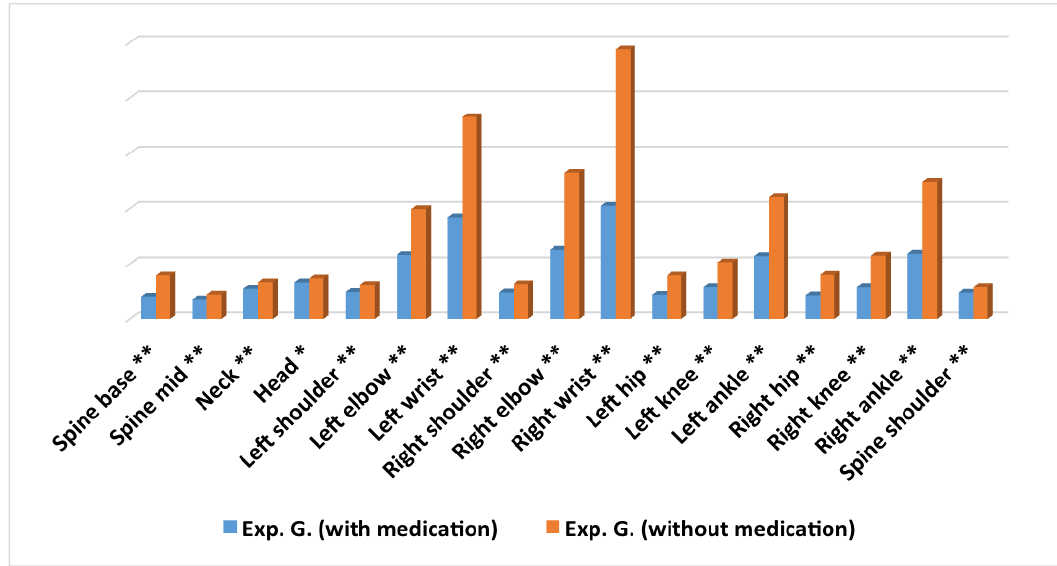
Figure 8. Average differences in movement for every joint within the experimental group with and without medication intake. ** = p < 0.001; * = p < 0.05.